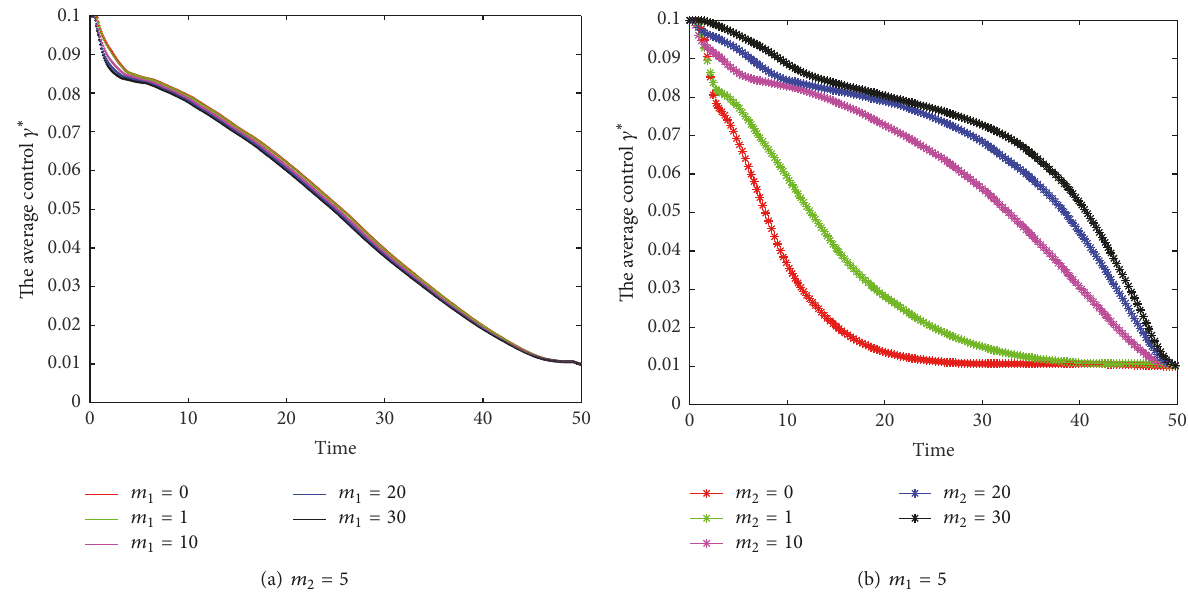
Figure 13: 𝛾 ∗ (𝑡) for different 𝑚 1 and 𝑚 2 for Example 3. Table 2: 𝐼 ∗ (𝑇) and 𝐽 under different control strategies with 𝑚 1 = 𝑚 2 = 2 for Example 2.